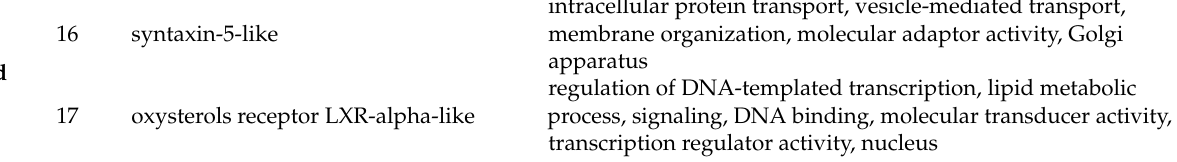
Figure 6. FPKM values of sex-specific genes in the gonads of Japanese eels. ( A , B ) Female-specific genes. ( C , D ) Male-specific genes. S, small (body length <15.0 cm); M, medium (body length 15.0– 19.9 cm); L, large (body length 20.0–24.9 cm). Functional and physiological interactions of the differentially expressed genes in E2- and genistein-treated eels were visualized using the STRING database, and the connected networks were detected in each group (Supplementary Figure S1). In both groups, the identified clusters concentrated on the glutamyl prolyl tRNA synthetase (EPRS), which was up-regulated in both E2- and genistein-treated eels, suggesting that EPRS modulates the gene expression.